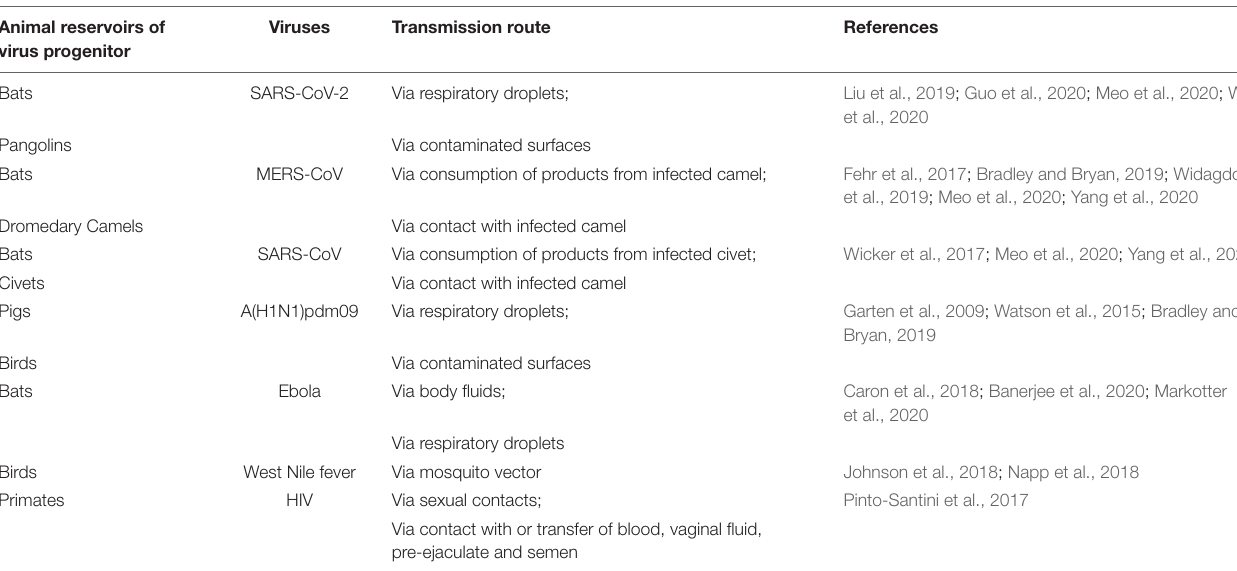
FIGURE 1 | Scheme of possible mechanism of prevention of emerging viral outbreaks by probiotics: Progenitor virus (PV) developed in primary host is able to “jump” to human (JH) directly or through intermediate host (JIH – “jump” to intermediate host). Intensive human-to-human transmission (HHT) is favorable condition for PV genetic developing (GD) making it more relative to human. This in the end contributes to appearance of highly pathogenic novel human virus (NHV), causing epidemic or pandemic outbreaks. Because of antagonistic relationship, probiotic bacteria (PB) can possibly inhibit (I) virus replication in all hosts with reducing its development and transmissions, in perspective, preventing outbreaks. PV, progenitor virus; JDA, jumping to domestic animals; JH, jumping to humans; HHT, human-to-human transmission; GD, genetic development; NHV, novel human virus; P, probiotic; I, inhibition. TABLE 1 | Examples of emerging zoonotic